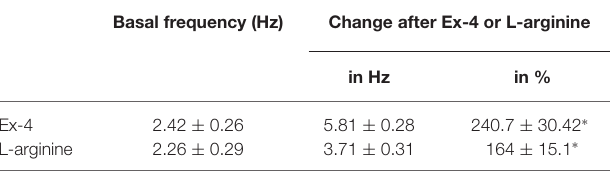
TABLE 3 | Changes in miniature postsynaptic currents (mPSC) frequency upon application of Exendin-4 or L-arginine. Basal frequency (Hz) Change after Ex-4 or L-arginine